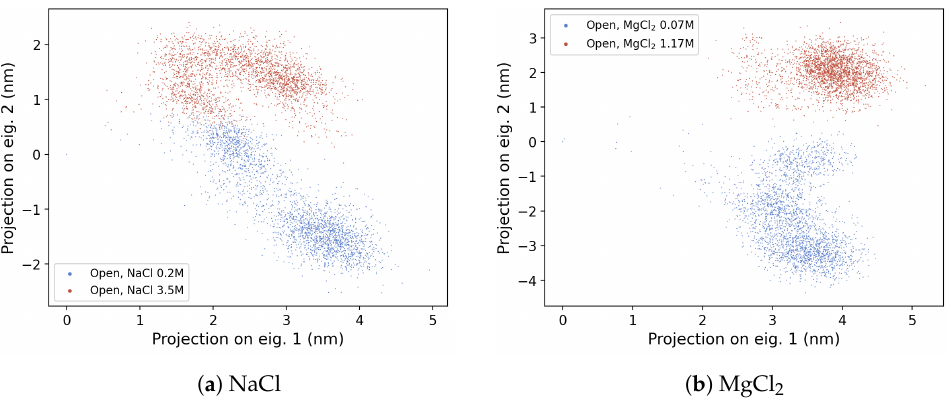
Figure 3. Projection of the concatenated MD trajectories of the open form of OleP-6DEB in NaCl and MgCl 2 buffer. In both cases, the frames corresponding to the low- and high-ionic strength conditions are reported in blue and red,